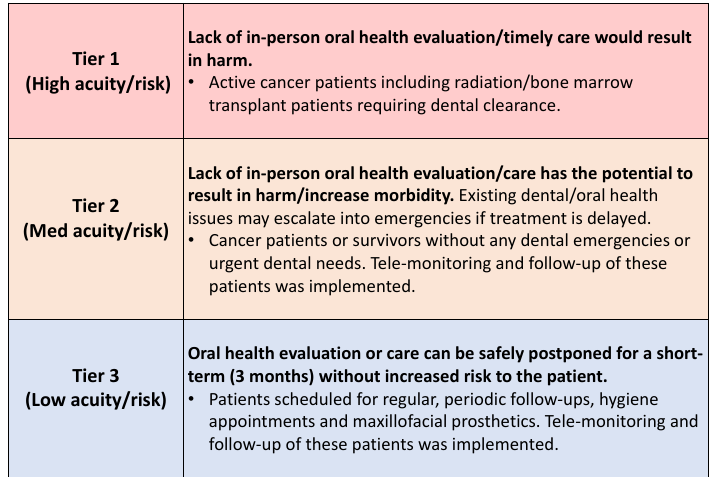
Figure 2. Three-tiered classification of patients based on their oral health needs for optimal scheduling of appointments during the pandemic.